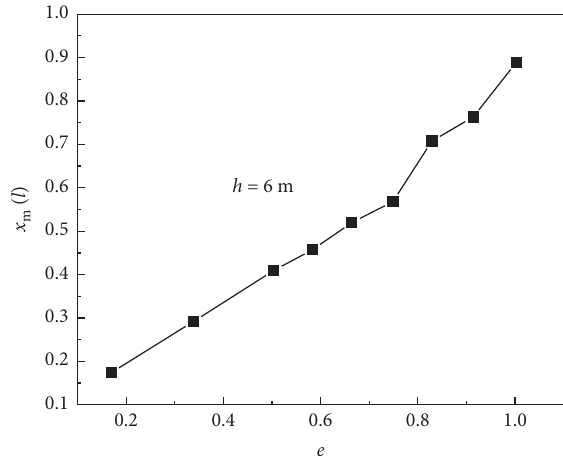
Figure 10: The relative position of the maximum settlement point of foundation varies with the degree of